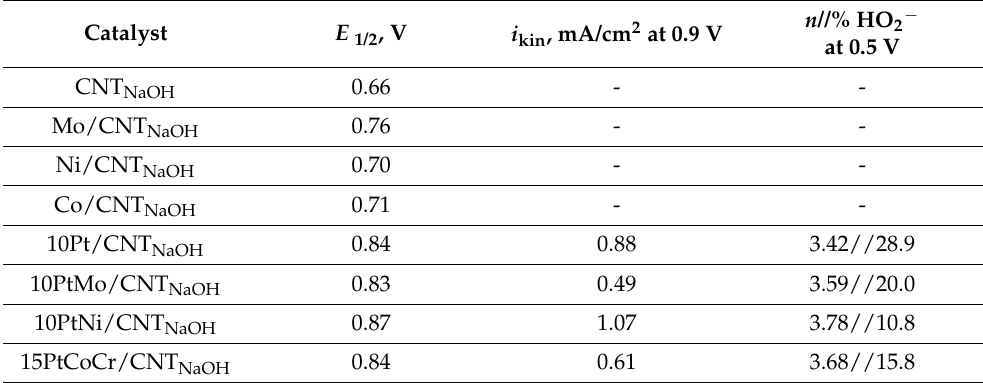
Table 3. Electrochemical parameters of